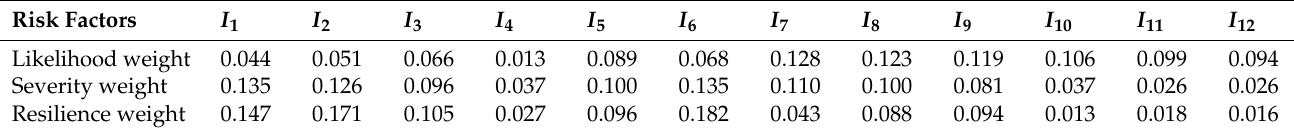
Table 15. Comprehensive risk factors’ weights.